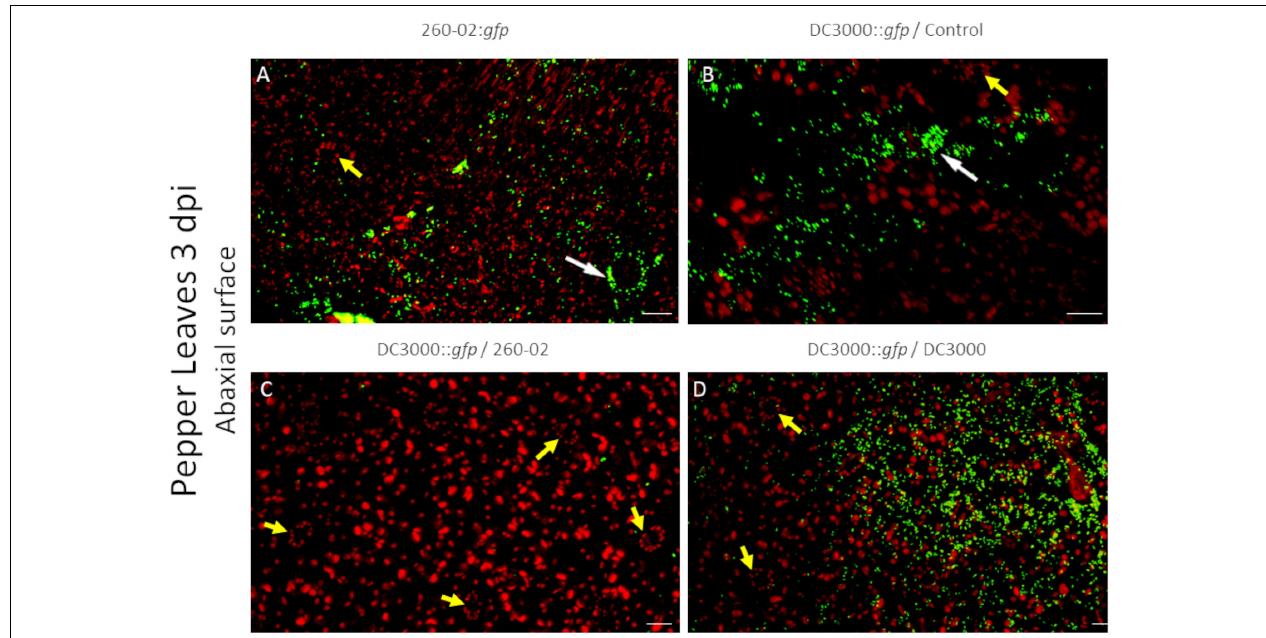
FIGURE 7 | Confocal microscopy on the abaxial surface of pepper leaves at 3 dpi. The panel shows representative pictures from the microscopy observations. In green is the fluorescence obtained by exciting with a wavelength of 488 nm, which produces fluorescence from the GFP used to tag the bacterial strains, in red that obtained by exciting with a wavelength of 594 nm, which produces autofluorescence from chlorophyll and visualizes the position of chloroplasts. Yellow color is given by overlap of red and green fluorescence. Panel (A) is from leaves experimentally inoculated with a suspension of strain 260-02: gfp cells; panel (B) is from leaves experimentally inoculated with a suspension of strain DC3000:: gfp cells taken from plants without any root treatment; panel (C) is from leaves experimentally inoculated with a suspension of strain DC3000:: gfp cells taken from plants treated at the root with strain 260-02; panel (D) is from leaves experimentally inoculated with a suspension of strain DC3000:: gfp cells taken from plants treated at the root with strain DC3000. White arrows point to stomata being colonized by bacterial cells, visible as green outlines of the guard cells and the stoma aperture; yellow arrows point to non-colonized stomata, visible as oval patterns in chloroplast position with a dark area in the middle. In each picture, the scale bar reported in the lower right corner represents 20 µ